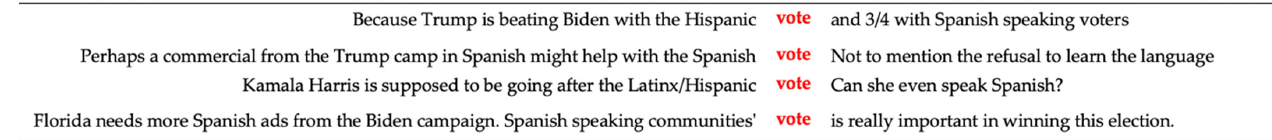
Figure 6. Concordance lines for vote that illustrate the role of Spanish in politicians’ (re-)election.